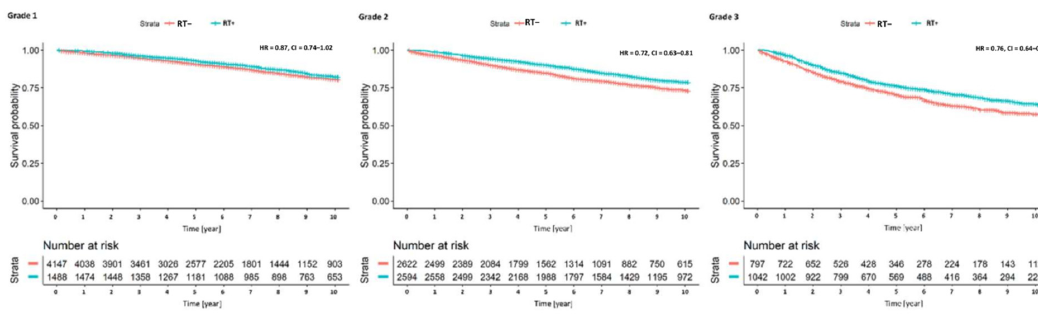
Figure 4. Grade-specific Kaplan-Meier survival plot of cases with and without radiotherapy, HR = hazard ratio with 95% confidence